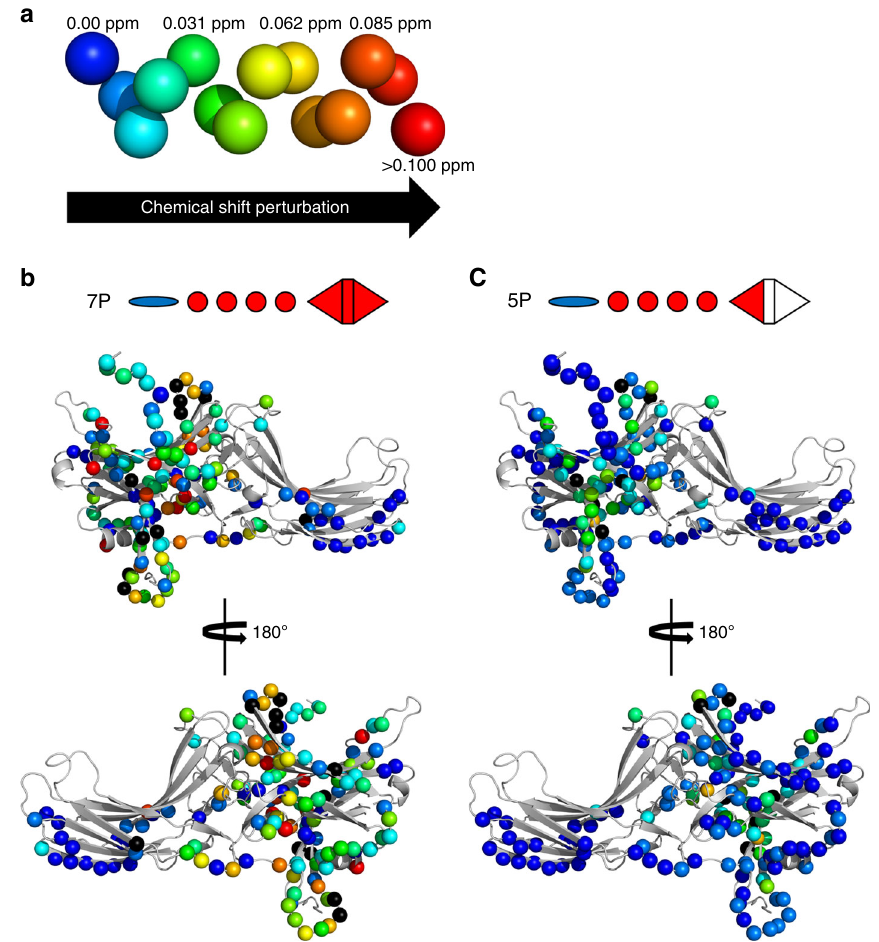
Fig. 6 Chemical shift perturbations measured by NMR titration series. a Color code indicating the magnitude of chemical shift perturbations, which are plotted on structural models of basal arrestin-1 (PDB accession 1CF1, molecule D) in ( b ) and ( c ). The rainbow spectrum represents the range of chemical shift perturbations: nonsigni fi cant (blue), minor (green), moderate (yellow), large (orange), and very large (red). Black marks residues whose signals showed strong line broadening which prevented the fi nal position to be determined, indicating signi fi cant changes in mobility of the residue or its surroundings bring them to the µ m-ms range. b Chemical shift perturbations measured for phosphopeptide 7P. c Chemical shift perturbations measured for phosphopeptide 5P. Note that the full-length C-terminus shown in these fi gures, which is not resolved in the structure, was modeled (see